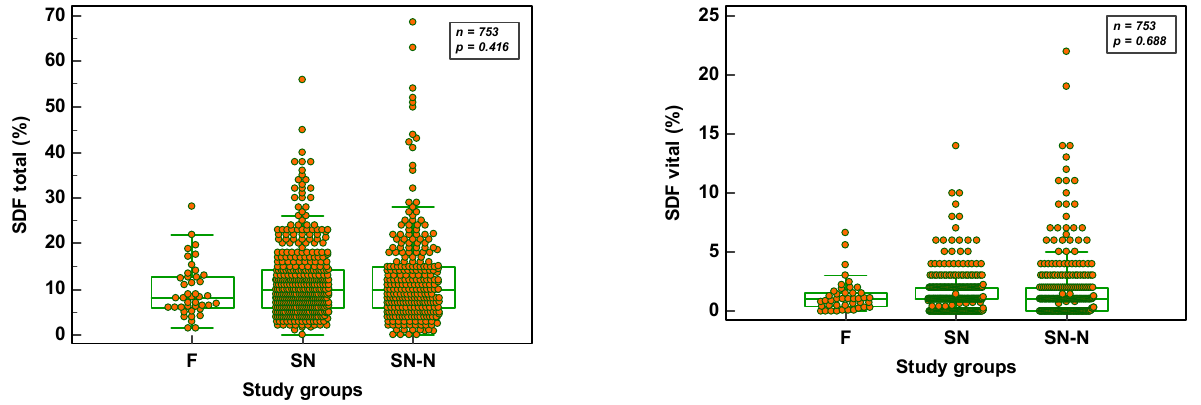
Figure 4. Total and vital SDF parameters in the different study groups (F = fertile population; SN = subfertile population with normozoospermia; SN-N = subfertile non-normozoospermic popula- tion).